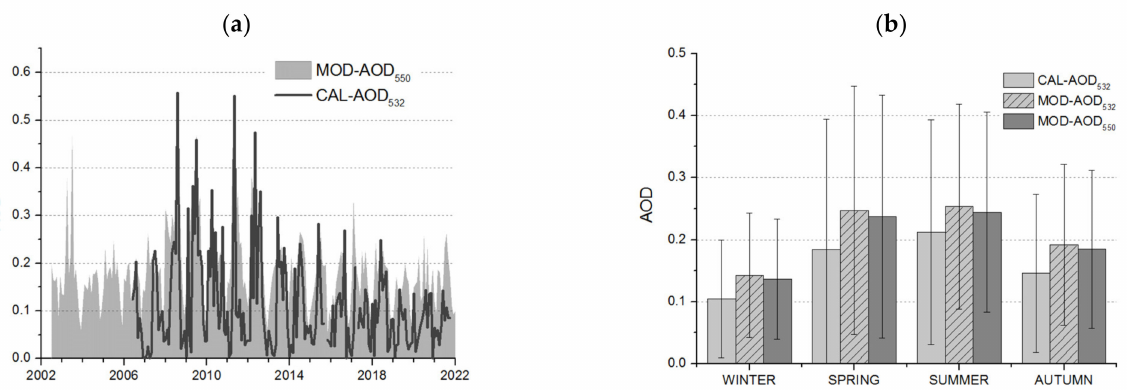
Figure 10. ( a ) Variations in monthly AOD 550 (shaded area) according to Aqua MODIS (MOD-AOD 550 ) data in 2002–2021 and average monthly AOD 532 (dark gray line) according to CALIPSO satellite (CAL- AOD 532 ) data in 2006–2021. ( b ) Average seasonal values of CAL-AOD 532 according to CALIPSO data (light gray) in 2006–2021, MOD-AOD 550 according to Aqua MODIS data in 2002–2021 (dark gray), and reconstructed MOD-AOD 532 according to MODIS AOD 550 and Ångström exponent data in 2002–2021 (light gray